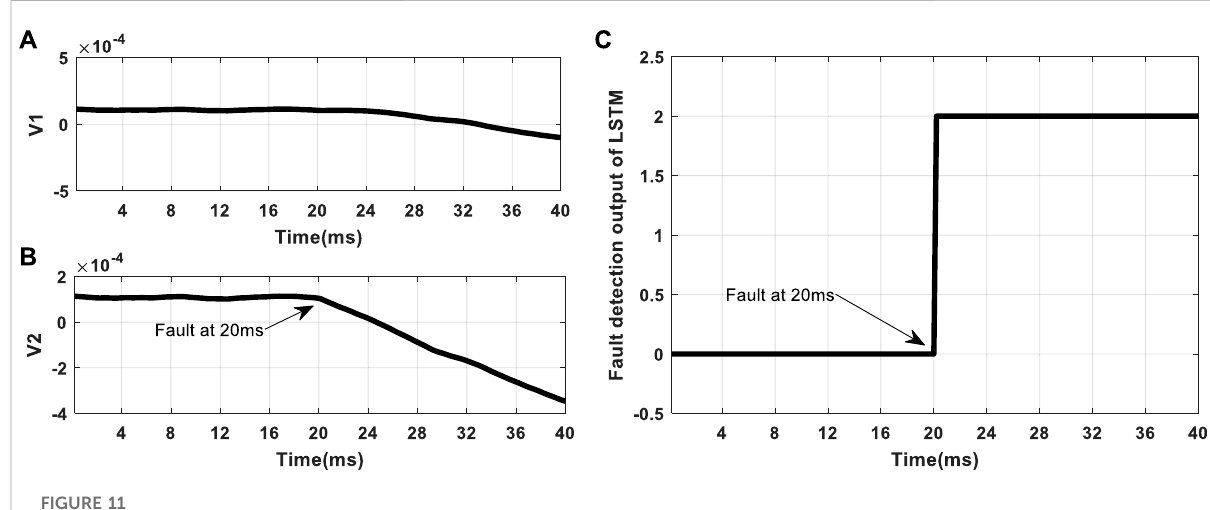
TABLE 8 Performance results of the backup relay during transmission line faults. Fault